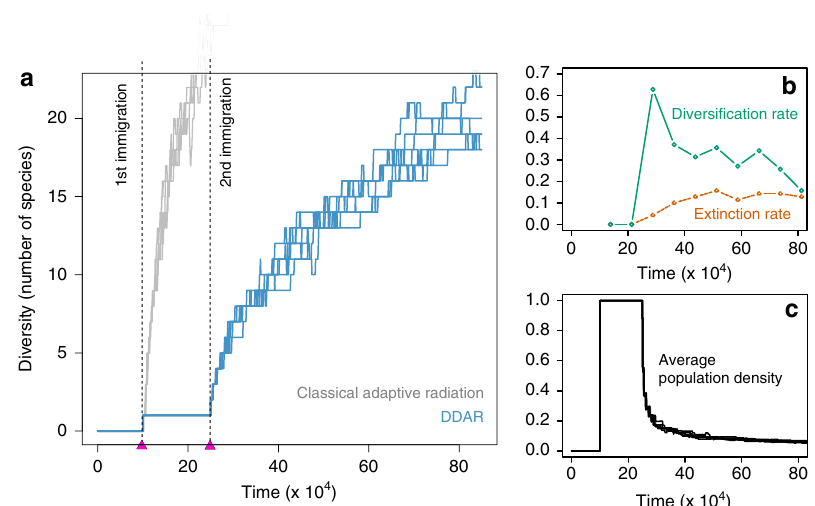
Figure 4 | Impact of DDAR on the dynamics of diversity. The number of species is shown as a function of time ( a ), in simulations starting from an empty community, under the niche scenario. Two sequential species colonizations were assumed (arrows). In a classical radiation (niche width s a ¼ 0.9), diversification starts after the first colonization (grey), whereas in the case of DDAR ( s a ¼ 1.1) it cannot start until the second colonization (blue). Note that in this case the DDAR curve saturates faster as the competition function is broader, and fewer species can be packed. Seven replicate simulations are shown in both cases. ( b ) shows the average diversification (solid line) and extinction (dashed line) rates as a function of time in the case of DDAR. ( c ) shows the average population density as a function of time in the case of